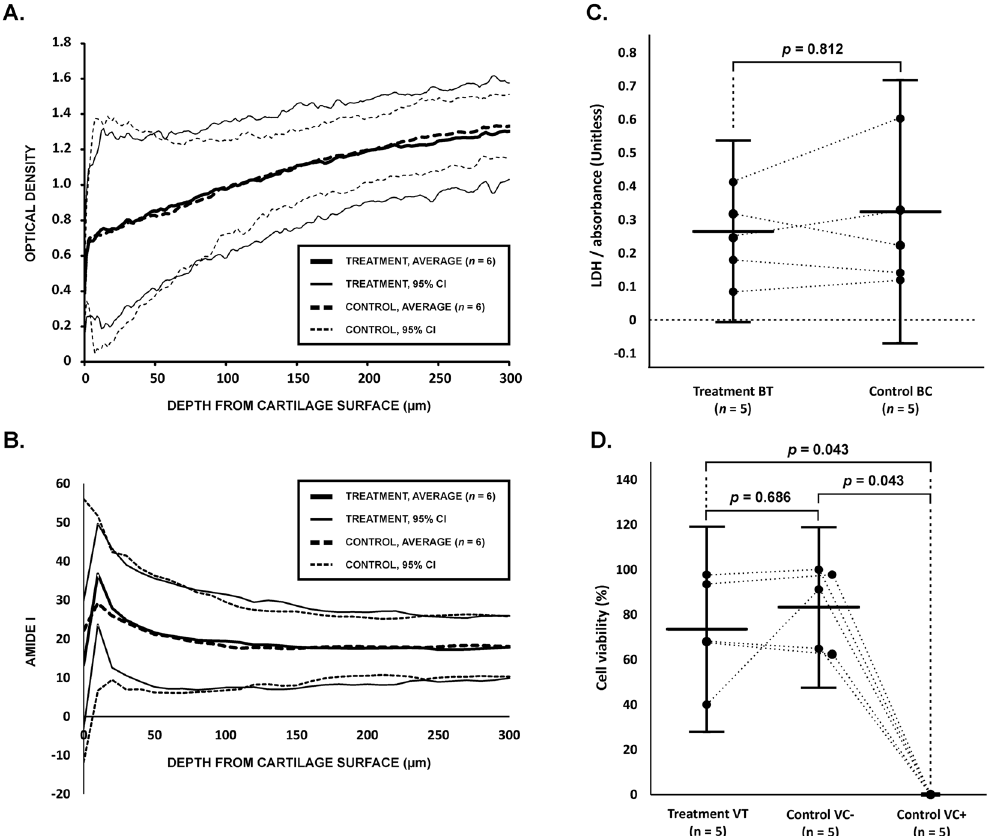
Figure 6. ( A ) Depth-wise optical density (mean ± 95% CI) of safranin O -stained articular cartilage (AC) sections detected with digital densitometry. The AC subjected to laser-ultrasonic (LU) exposure has a similar depth-wise optical density profile as the adjacent control tissue. The result suggests that no proteoglycan loss is induced by LU exposure. The analysis was applied to AC surface (0–300 µ m) since leakage of proteoglycans, if present, would be expected to occur in superficial AC. ( B ) Depth-wise amide I peak absorbance (mean ± 95% CI, arbitrary units) of non-stained articular cartilage (AC) sections detected with Fourier transform infrared image imaging. The result suggests that no collagen loss is induced by LU exposure. The analysis was applied to AC surface (0–300 µ m). ( C ) Content of lactate dehydrogenase (LDH) was optically quantified as absorbance in the supernatant 24 h post LU and compared with adjacent controls not exposed to LU. The difference was statistically insignificant (p = 0.812) suggesting no cell death. ( D ) Cell viability assessment of AC stained with dead/live cell kit and EPI fluorescence microscopy demonstrate that cell viability was chondrocyte was not different (p = 686) in AC exposed to LU compared to negative control samples VC − . This result is in line with LDH experiments suggesting no immediate chondrocyte death due to LU. All statistics ( A – C ) are presented as mean ± 95% CI. The p-values < 0.05 were considered statistically